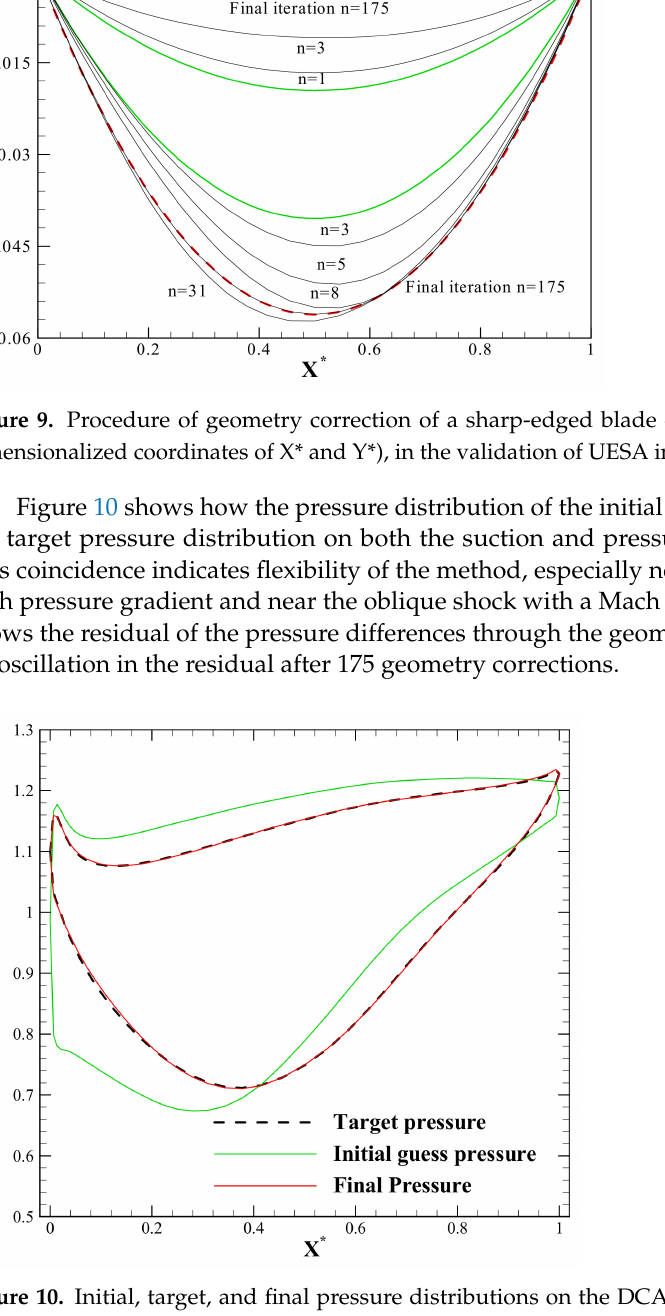
Figure 10. Initial, target, and final pressure distributions on the DCA blade surfaces versus non- dimensionalized X*—coordinate, in the validation of UESA in transonic flow